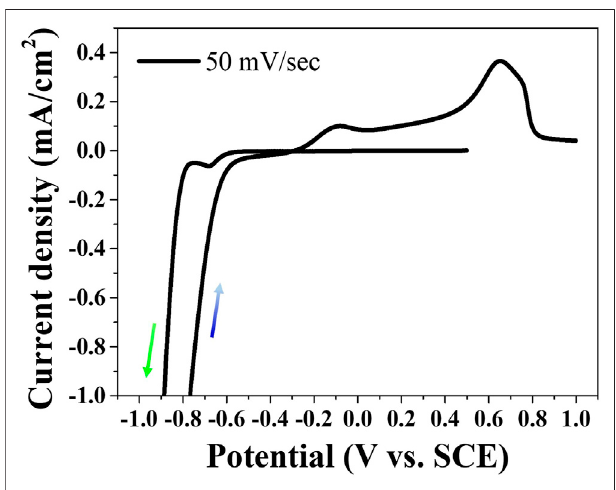
FIGURE 1 | Cyclic voltammetry behavior for Ni-P